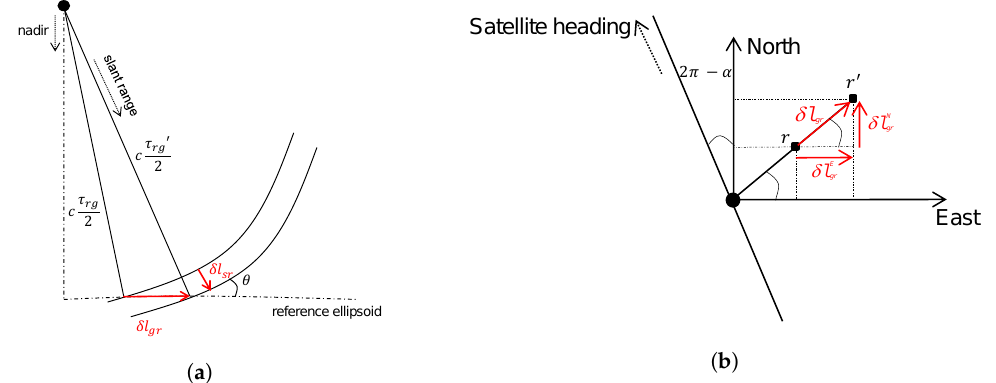
Figure 2. Timing bias in range and its effect on the geocoded coordinates. ( a ) range timing error and its impact on geocoding in the ground range δ l gr ; ( b ) projection of δ l gr onto the East δ l E gr and North δ l N gr components using satellite heading angle α .